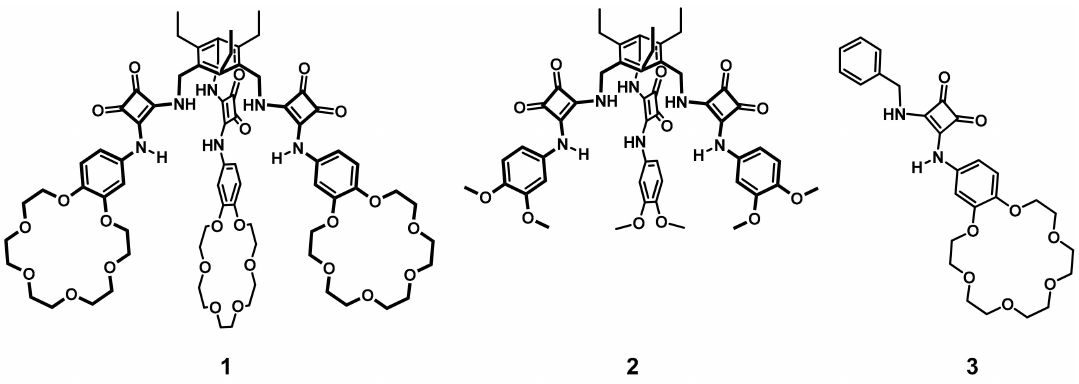
Figure 1. Structures of studied receptors 1 – 3